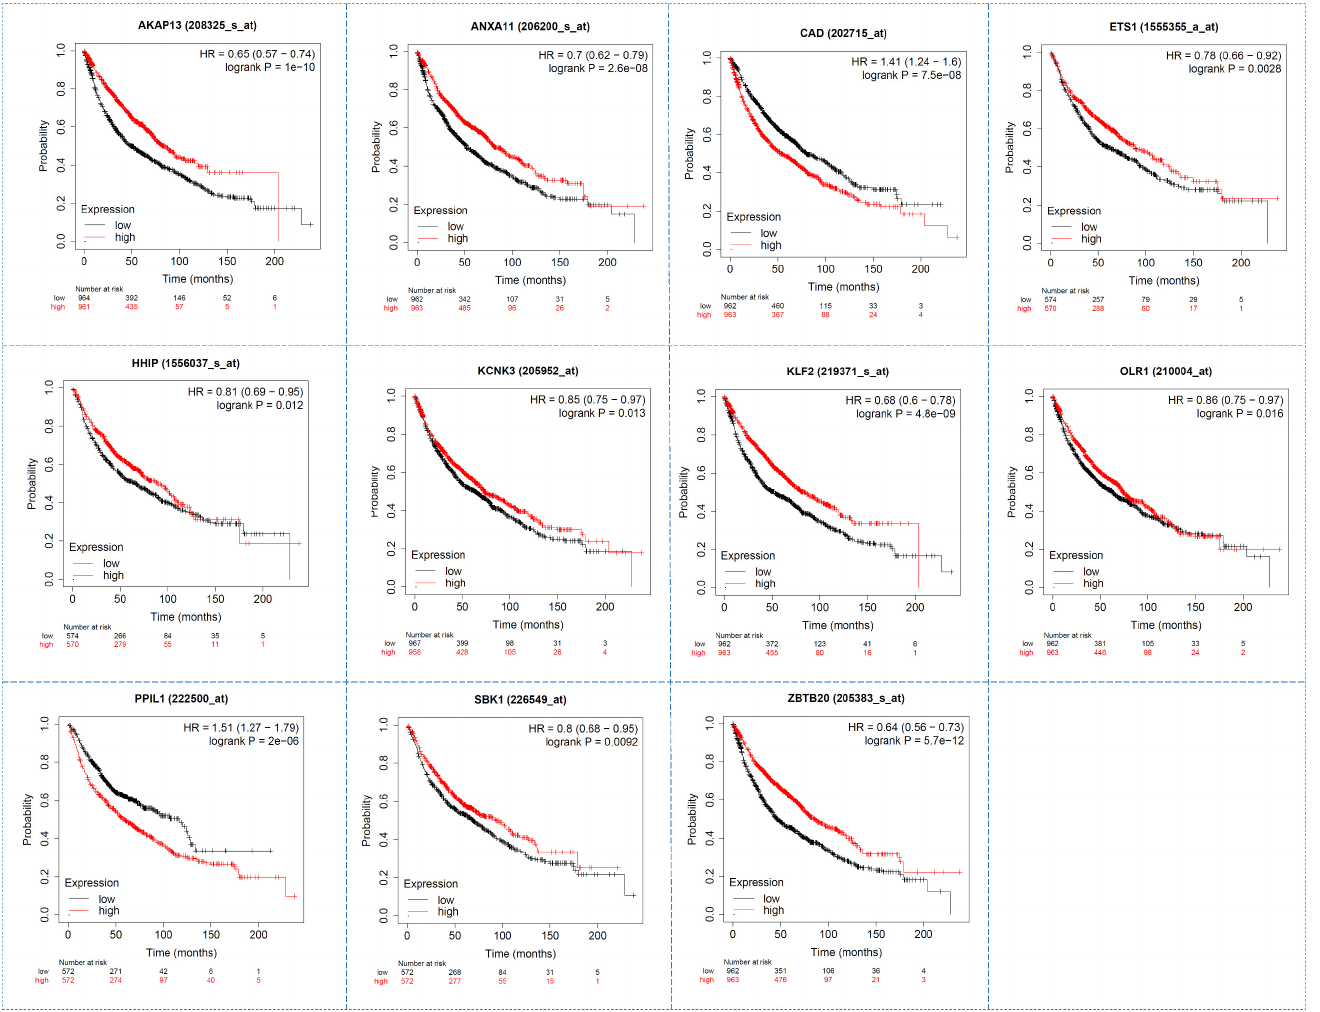
Figure 7. Survival analysis of hub genes by the KMplot tool. Here, we only show 11 genes with a significant p -value ≤ 0.05.